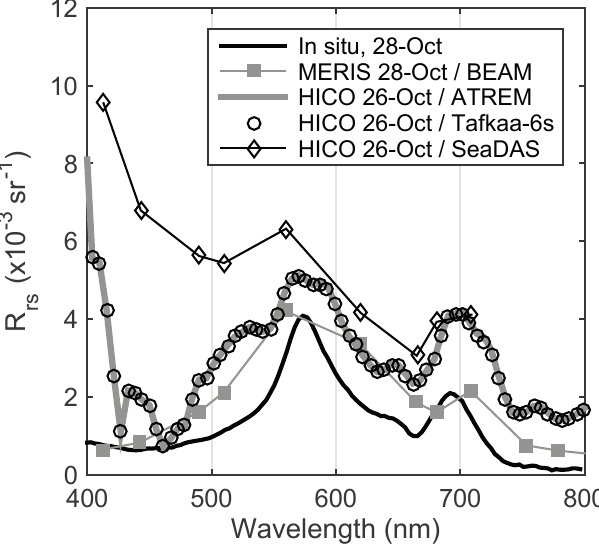
Figure 9. Fall 2011 study: Ground truth optical measurements acquired along the periphery of a red tide patch on 28 October 2011 (location shown in Figure 8b). The in - situ R rs spectrum was acquired 59 min after the MERIS image. HICO spectra are 3 × 3 pixel means from the location shown in Figure 7c (zoom panel). The Tafkaa 6s and ATREM results are nearly identical, and the lines are completely overlaid at the resolution of this